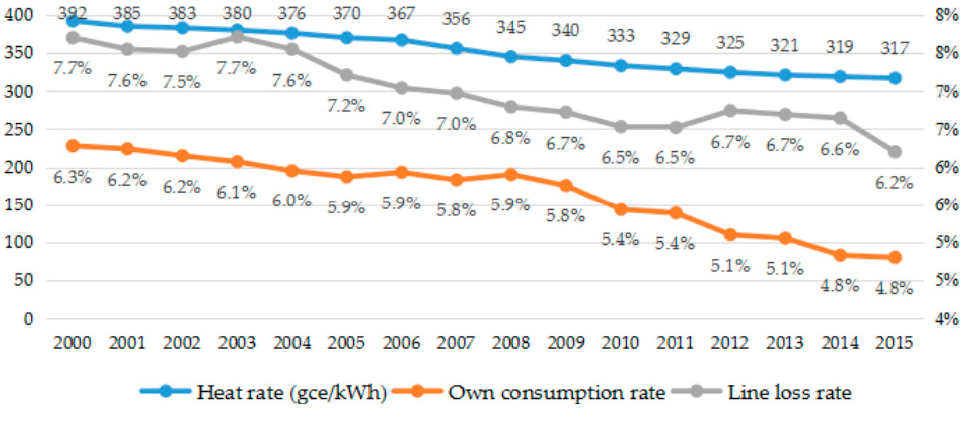
Figure 9. Heat rate of power supply and own consumption rate in China’s power sector.